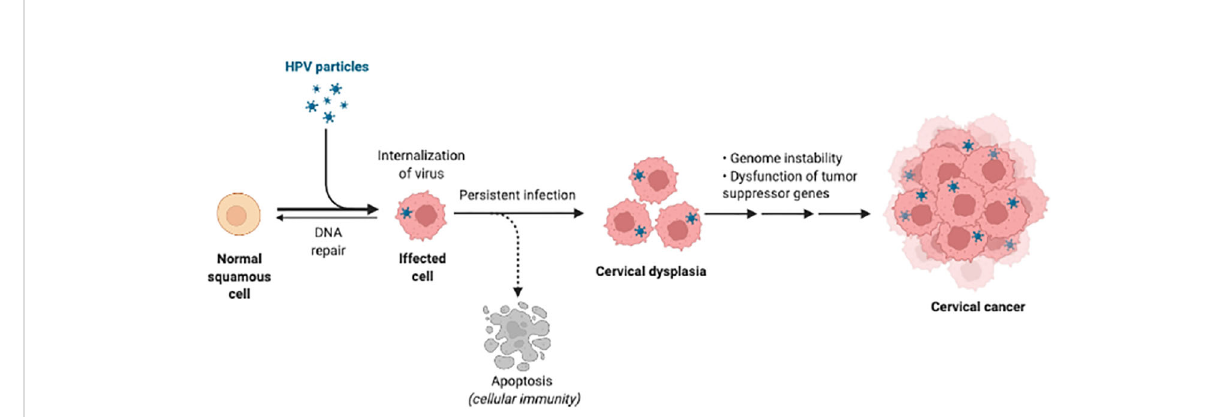
FIGURE 1 HPV infection and carcinogenesis. The HPV is internalized into the squamous cells fi rst and persistent infection can cause DNA integration. Then infected cells are in dysfunction and develop to cancer. Created in